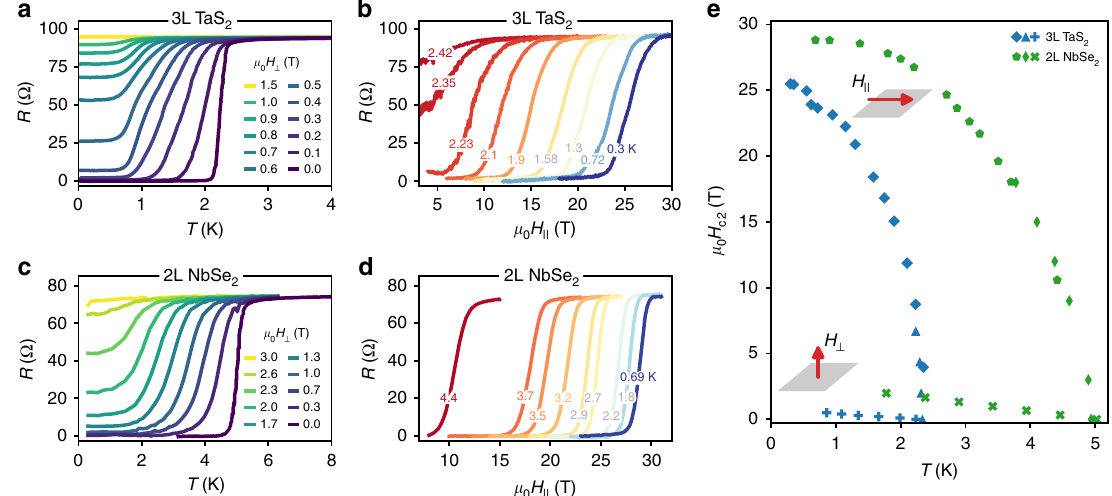
Fig. 3 Perpendicular and parallel magnetic fi eld dependence. a Temperature dependence of longitudinal resistance of trilayer (3L) TaS 2 in the presence of an applied magnetic fi eld H ⊥ in the out-of-plane direction. b Magnetic fi eld dependence of the TaS 2 resistance for a fi eld H || applied in an in-plane direction, for a few constant temperatures as indicated. The fi eld value H jj at which the resistance transitions to a zero-resistance state at a fi xed temperature is c2 equivalent to the transition temperature T c of the superconducting state for a fi xed fi eld. c Temperature dependence of the bilayer (2L) NbSe 2 sample for a few perpendicular fi elds. d In-plane fi eld dependence of the same NbSe 2 sample for a range of constant temperatures. e Temperature dependence of the upper critical fi eld H c2 of both samples as extracted from the 50% normal state resistances from the data shown in a –